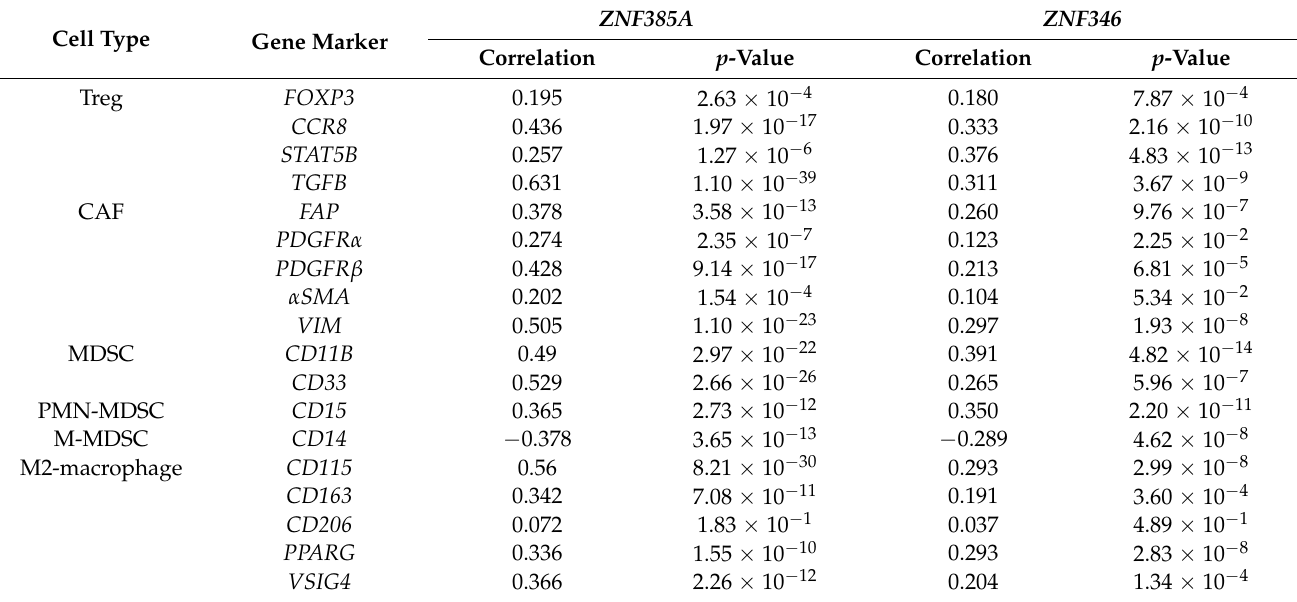
Table 1. Correlations between ZNF385A , ZNF346 , and gene markers of immunosuppressive cells after adjusting for tumor purity via